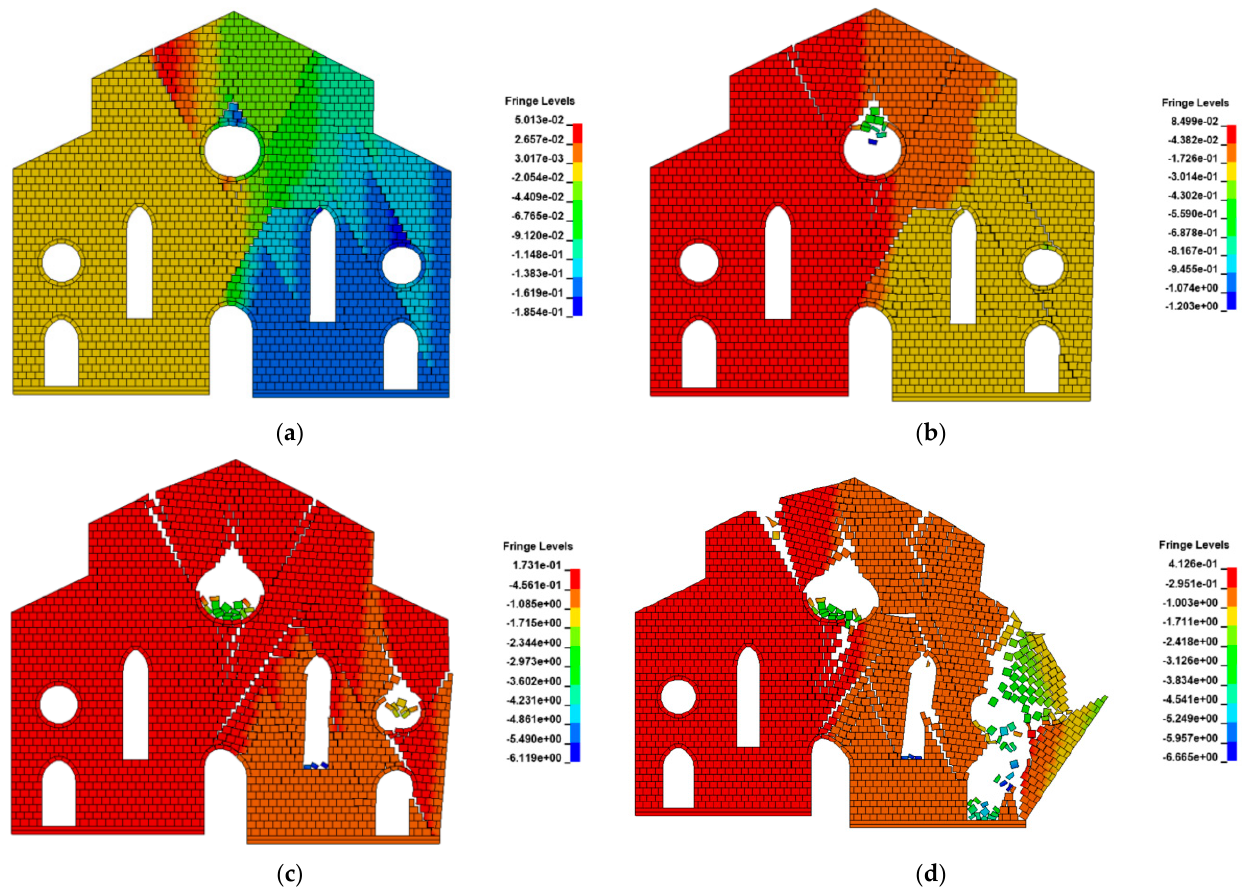
Figure 7. The collapse process of the church façade (in the contour of vertical displacement, unit: m): ( a ) d = 0.15 m; ( b ) d = 0.245 m; ( c ) d = 0.48 m; ( d ) d = 0.685 m.